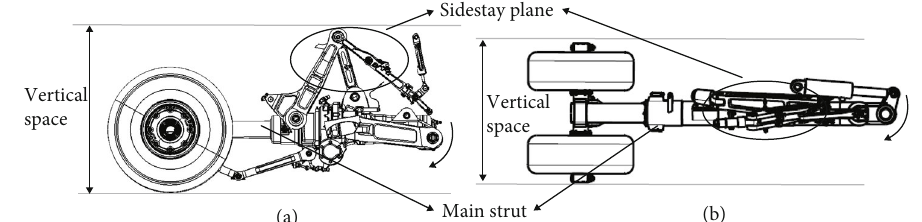
Figure 1: Vertical storage space of 2D versus 3D landing gear.